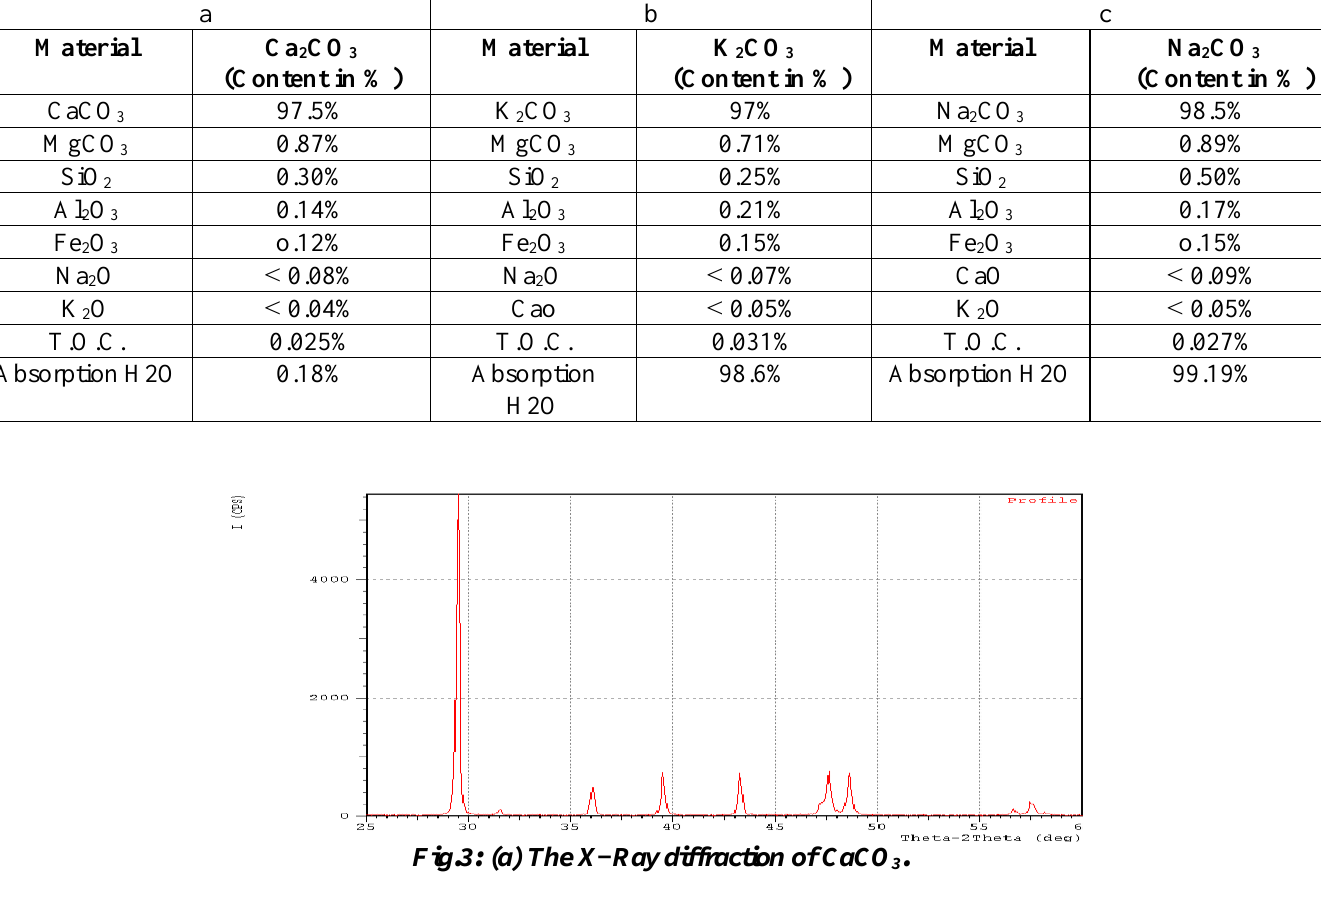
, (b) chemical composition of the K 3 composition of the Na CO 2 3.